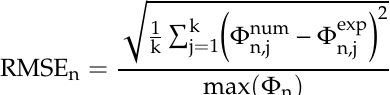
f n f f ). Using this procedure, considering n n